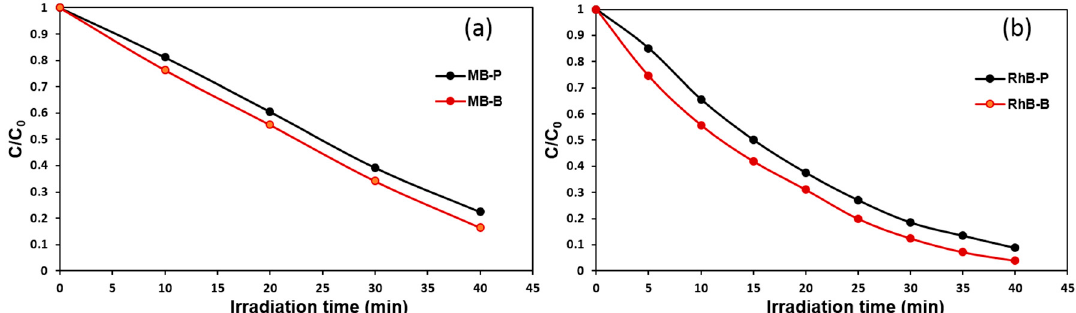
Figure 8. The plot of C/C 0 vs. time of irradiation for Bi 2 WO 6 films ( a ) for MB dye and ( b ) for RhB dye.